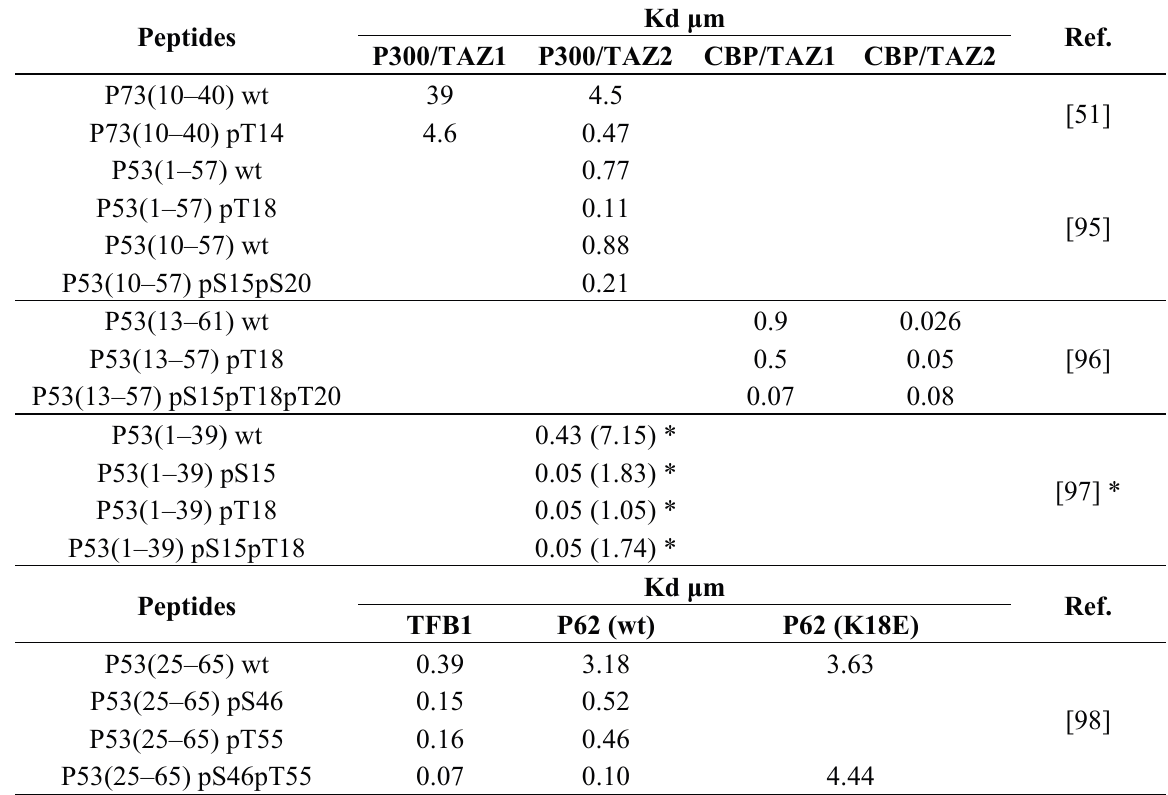
Table 4. Experimental dissociation constants of p53/p73 N -terminal with